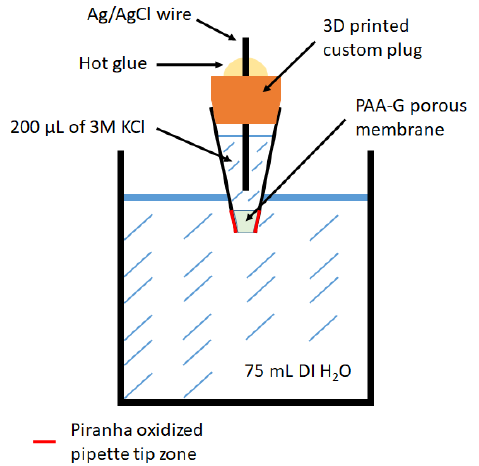
Figure 1. Scheme representing the design of Ag/AgCl-based reference electrode and setup for the permeability tests. Detailed construction of Ag/AgCl-based reference electrode is described in Section 2.2; detailed description of permeability tests is presented in Section 2.4.